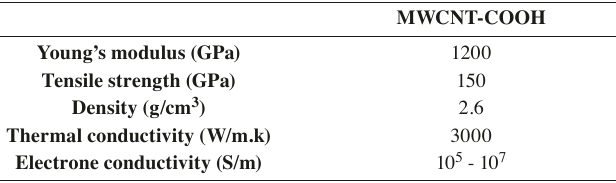
Tab. 1: Physical properties of the MWCNT-COOH.